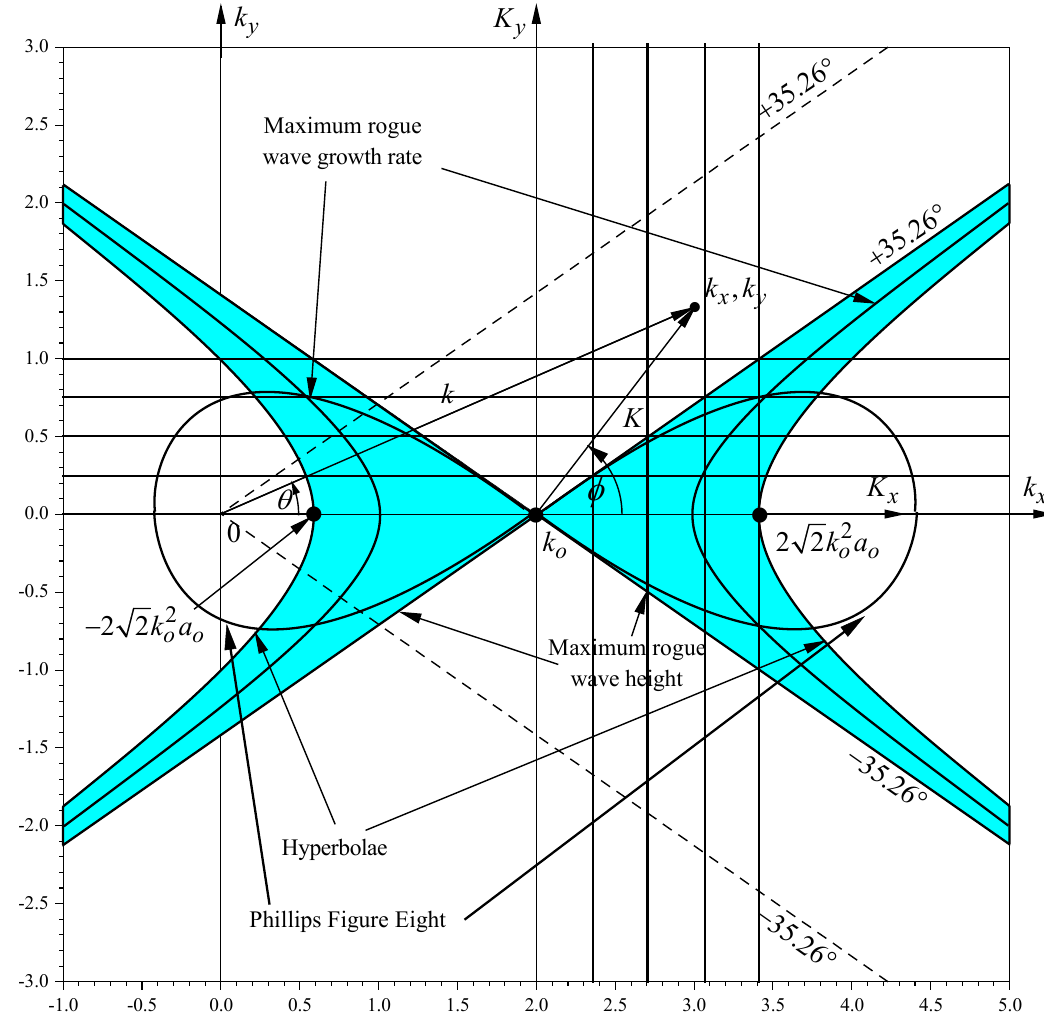
Figure 4. Boundary of modulation dispersion relation for the 2 + 1 NLS equation. The cyan region is where the unstable modes occur in the spectrum (this is where the actual breathers of the quasiperiodic solutions of the equation reside). The figure eight shows where the Phillips four-wave interactions